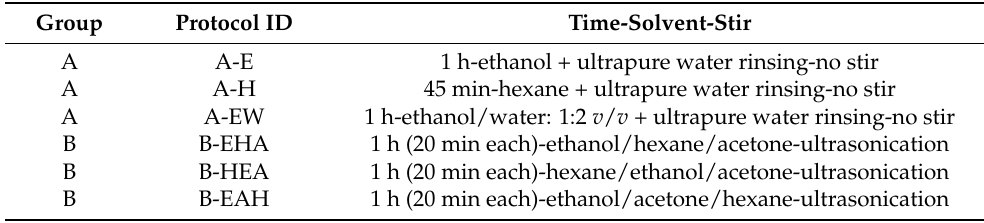
Table 1. Parameters of washing protocols applied in this